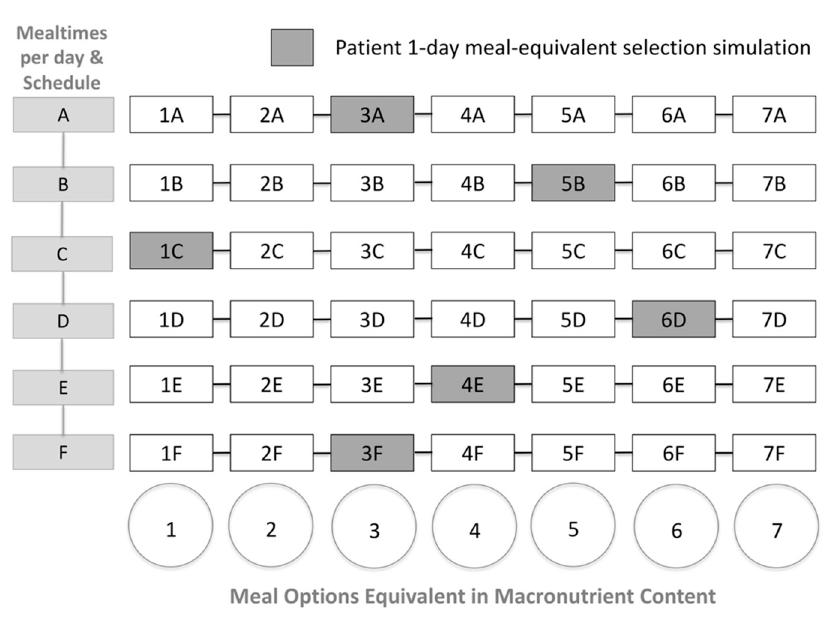
Figure 3. Patient 1-day meal-equivalent selection simulation exemplified in an individualized macronutrient meal-equivalent menu